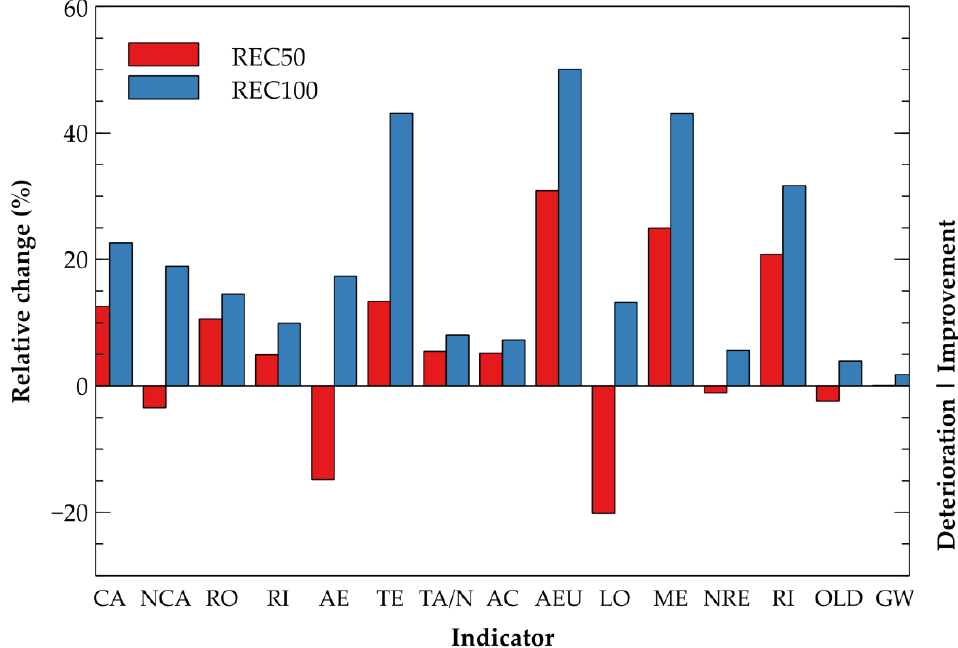
Figure 13. Relative change of the environmental indicators—recycling scenarios.